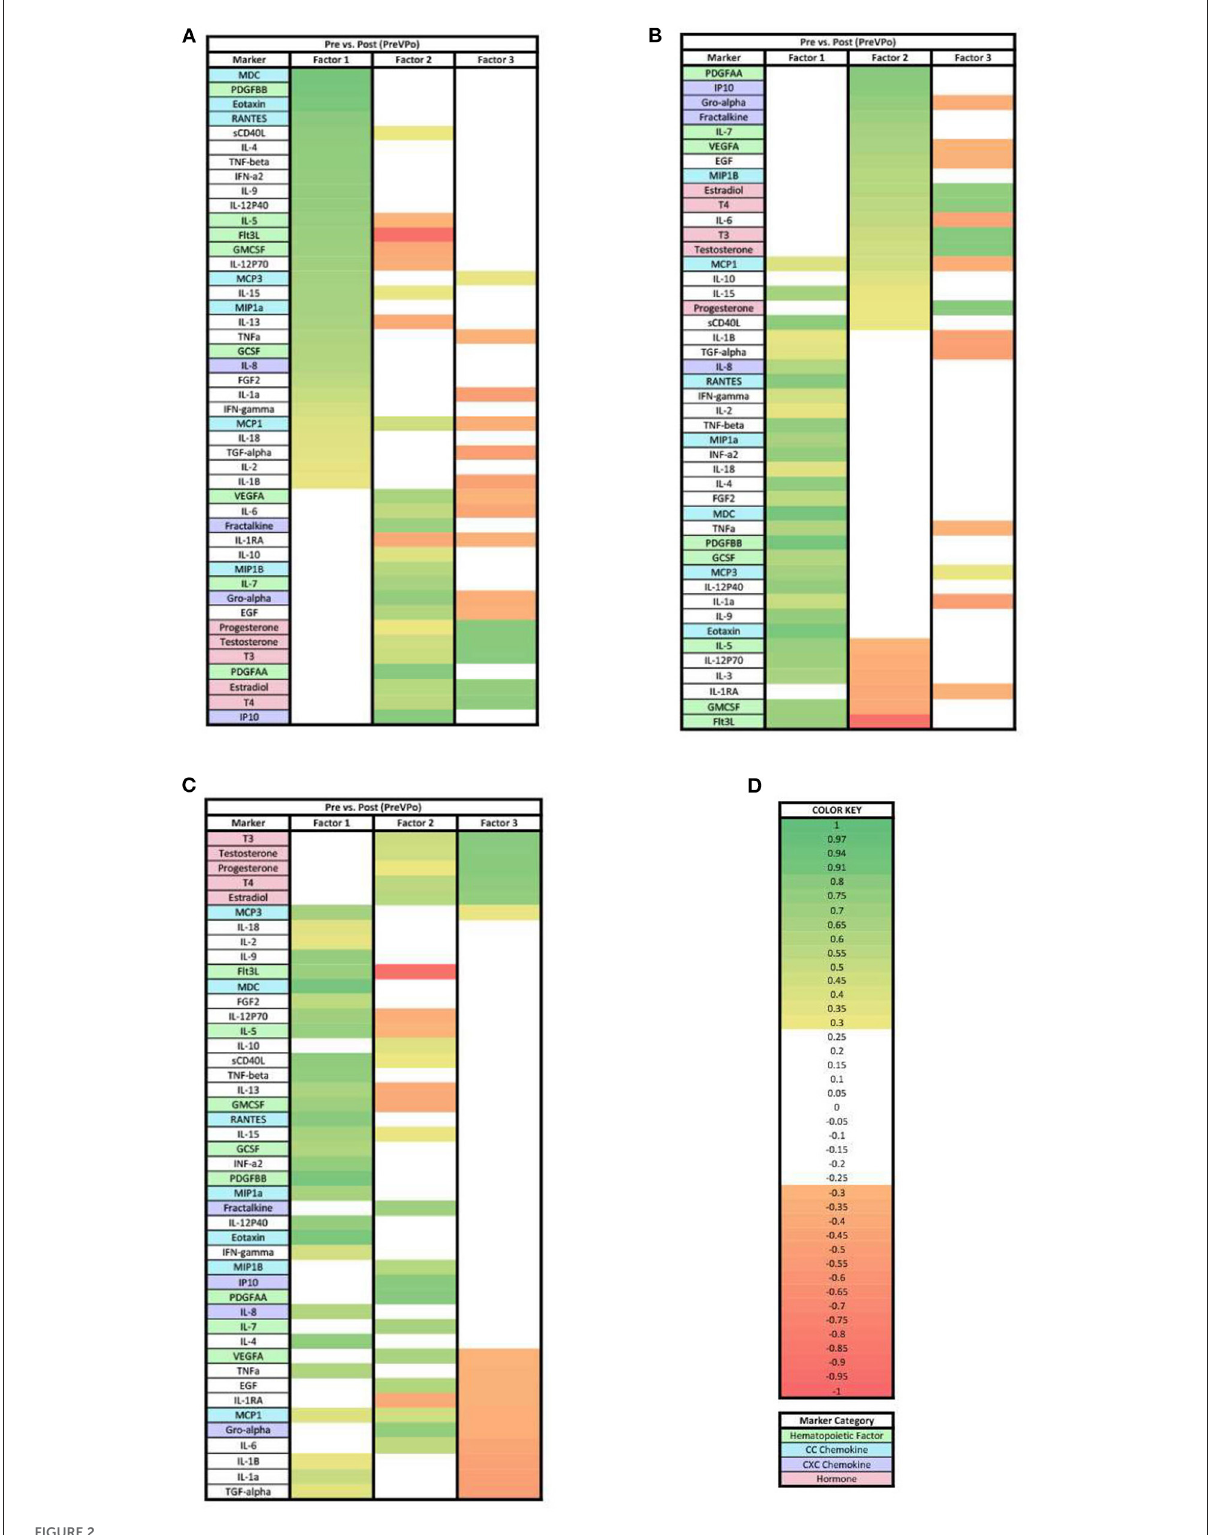
FIGURE2 Heat maps of the pre-stress vs. post-stress (PreVPo) analysis of loadings ≥ 0.3. (A) Biomarkers sorted from highest to lowest loading in PreVPo factor 1. (B) Biomarkers sorted from highest to lowest loading in PreVPo factor 2. (C) Biomarkers sorted from highest to lowest loading in PreVPo factor 3. (D) Color key for PreVPo loadings ≥ 0.3, sorted top to bottom from most positive to most